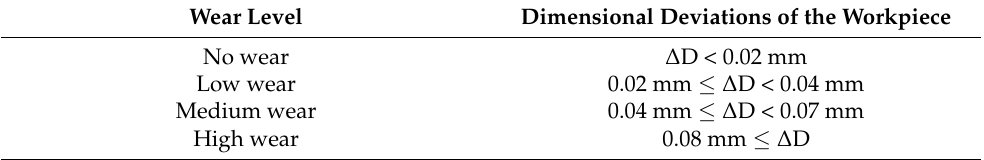
Table 2. Limit values of the wear